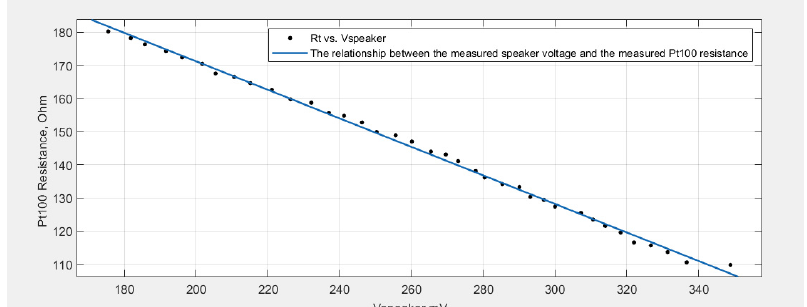
Figure 8. The curve fitting using cftool.